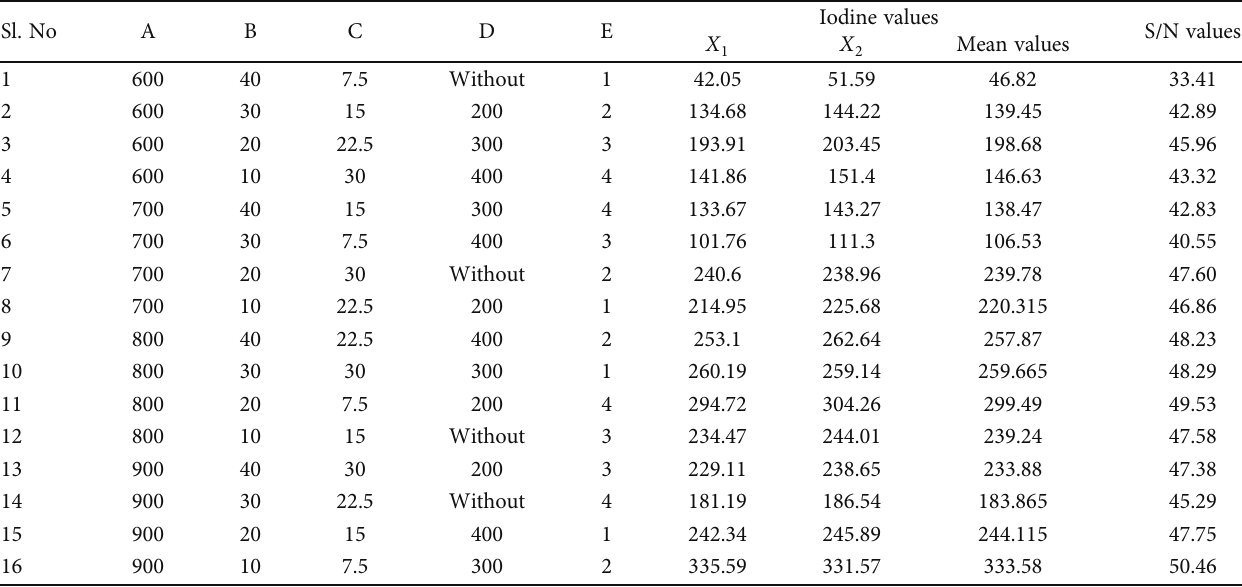
Table 2: Iodine values of di ff erent process parameters on the adsorption.